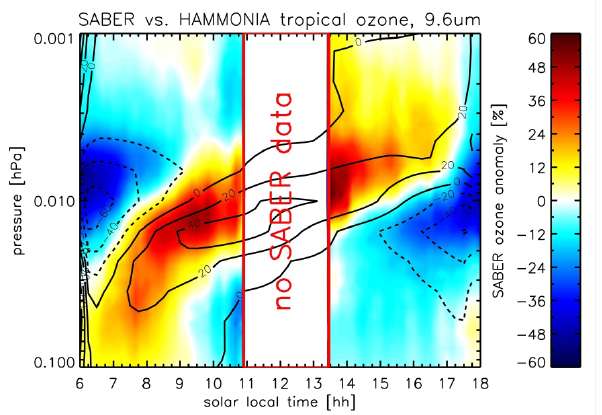
Fig. 5. Same as Fig. 4, but for SABER 1.27µm retrieval.